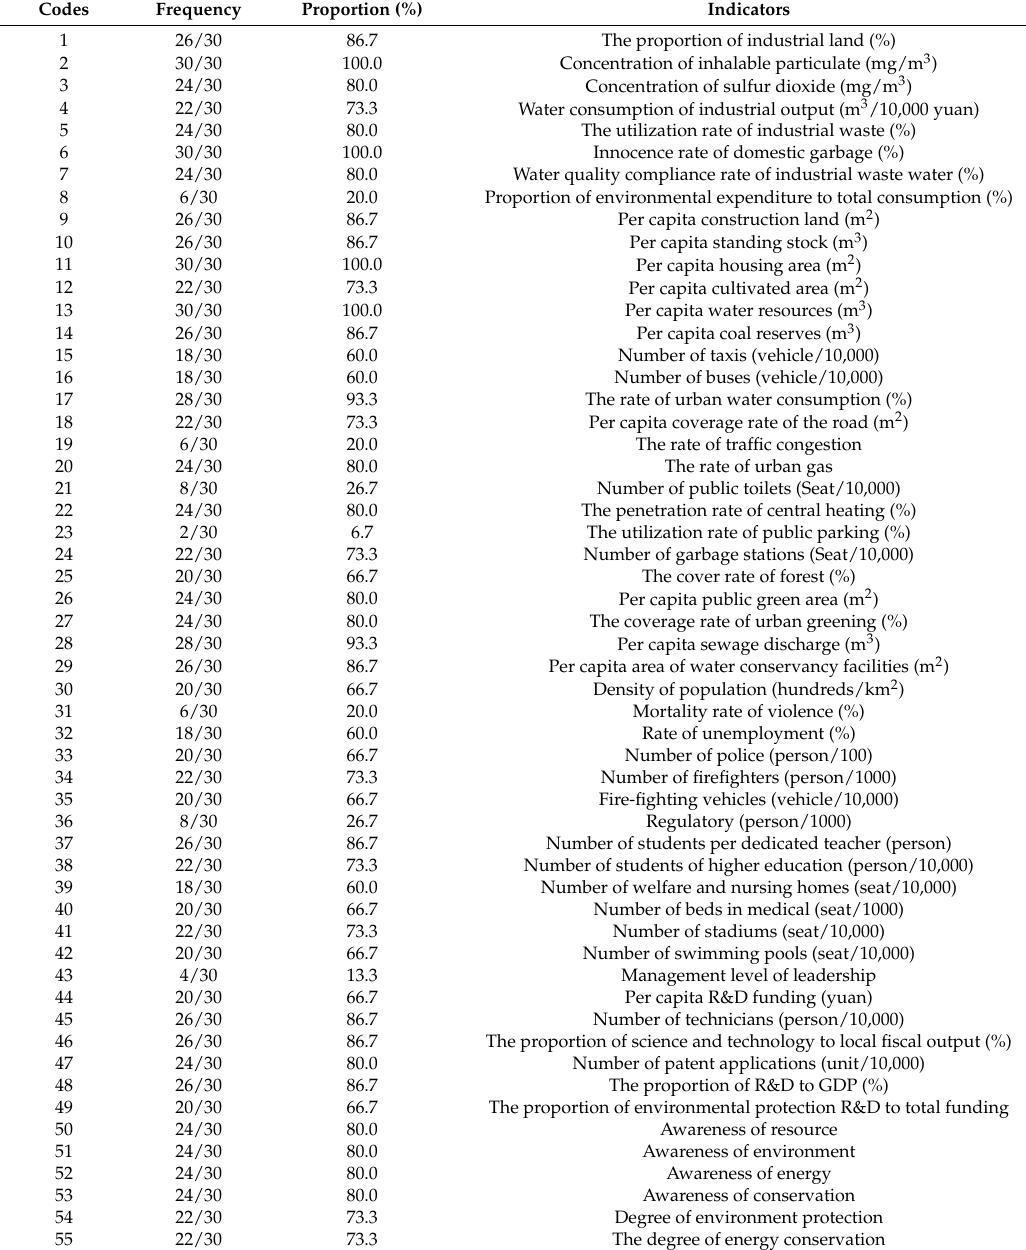
Table 4. Identification of terminal